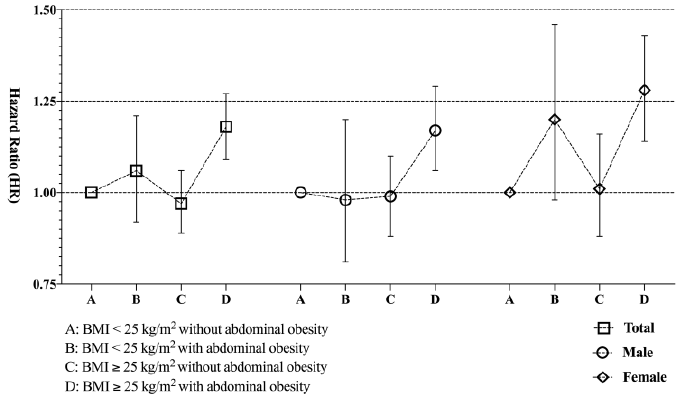
Figure 1. Impact of abdominal obesity on the association between BMI and risk of glioma develop- ment.